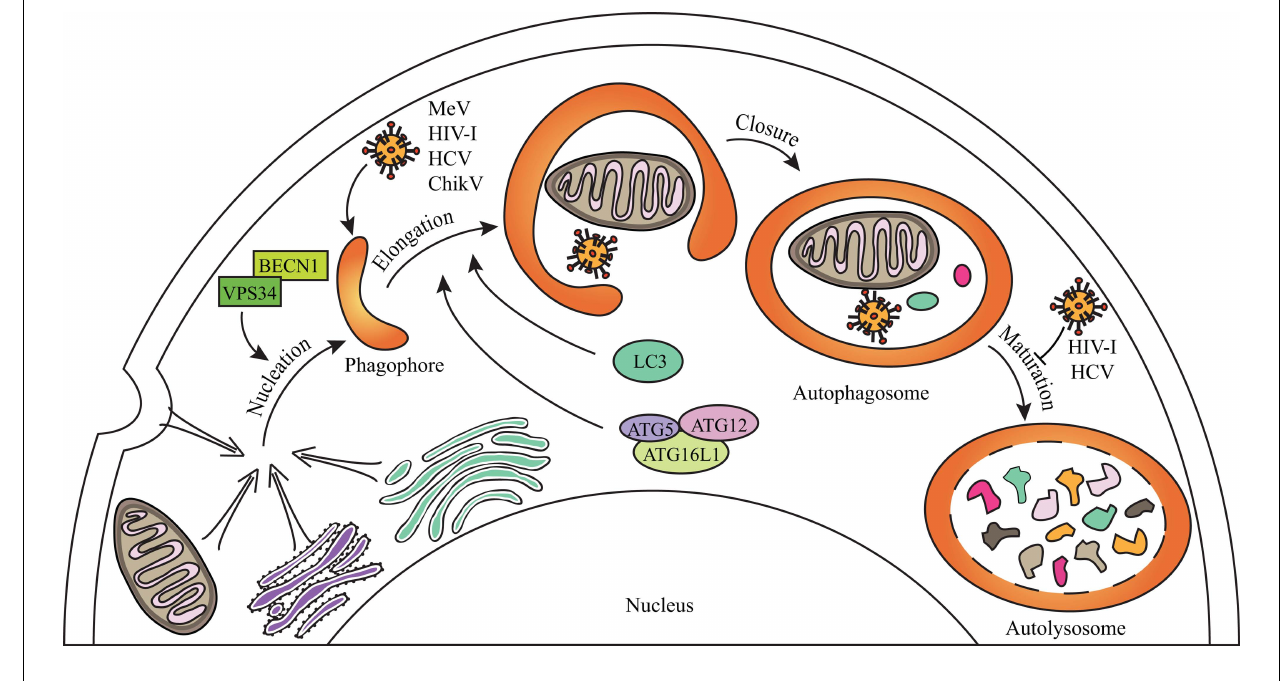
FIGURE 1 | General steps of mammalian autophagy. Autophagy engulfs portions of the cytosol through three main steps.The nucleation induces the formation of an isolation membrane which could emerge from different membrane sources (the endoplasmic reticulum, the Golgi apparatus, the plasma membrane, the mitochondria) to form a phagophore which elongates to form double-membraned autophagosome vesicles. Autophagosome can sequester cytosolic material including senescent organelles such as mitochondria, long-lived proteins or intracellular pathogens, through